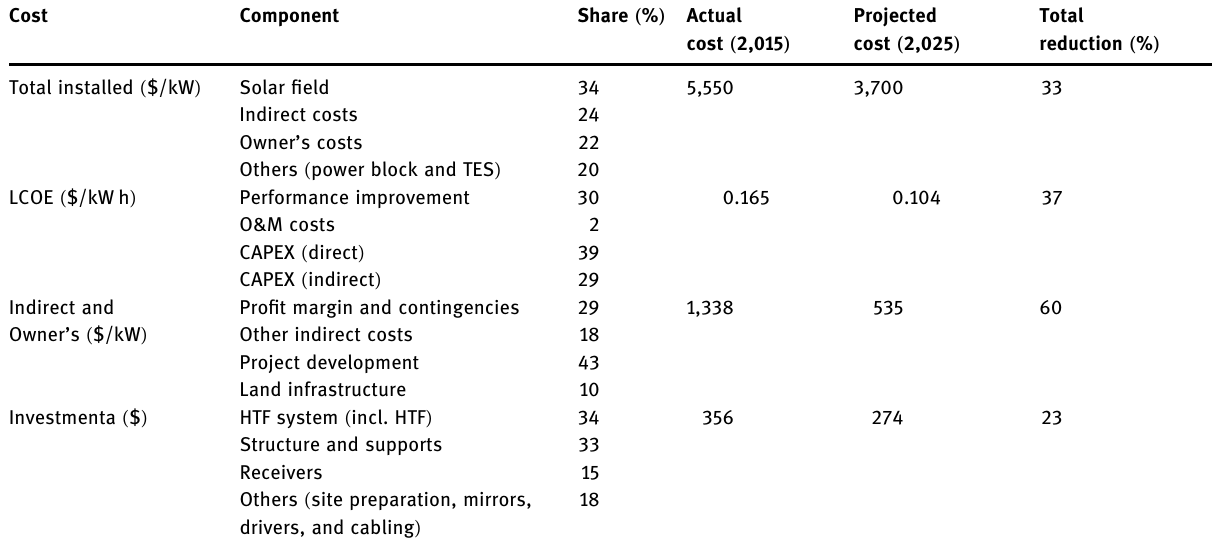
Table 16: Predictions of cost reductions for CSP plants [ 158,160